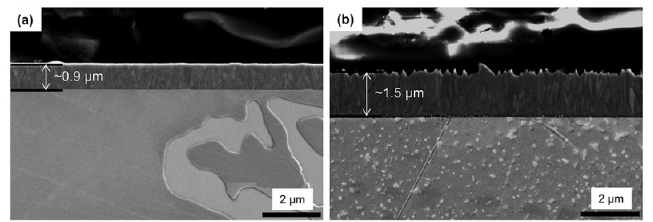
Figure 5. Cross-sectional SEM micrographs showing the PVD ( a ) and CVD ( b ) TiN coating layers on the mirror-polished Co–Cr alloy substrate (10000×).